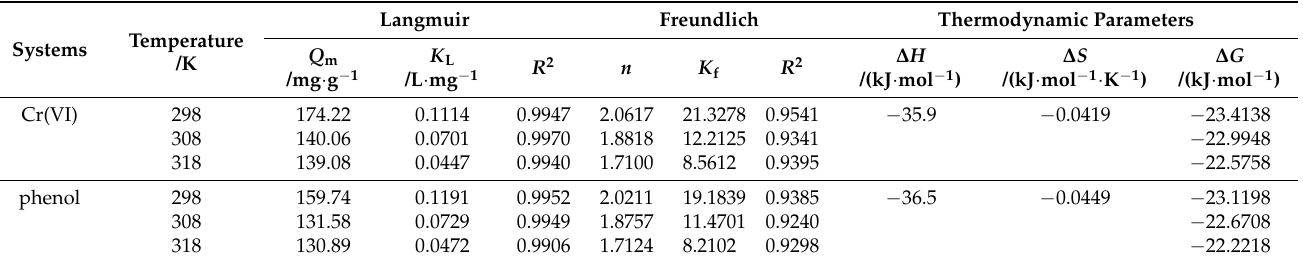
Table 3. Adsorption isotherm constants and thermodynamic parameters for Cr(VI) adsorption on S1 and phenol adsorption on